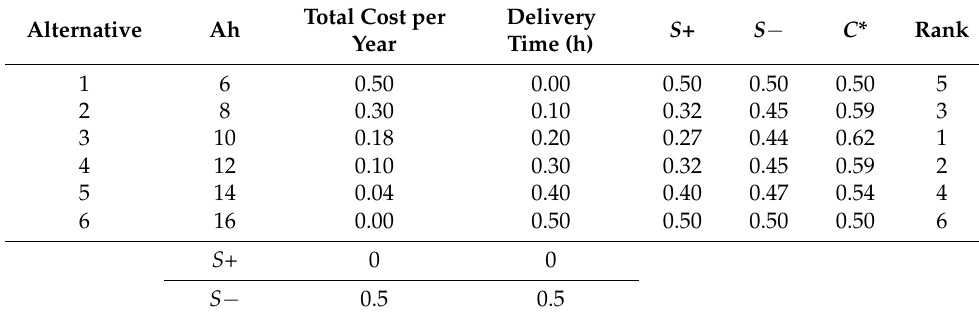
Table 7. Final ranking of the alternatives.